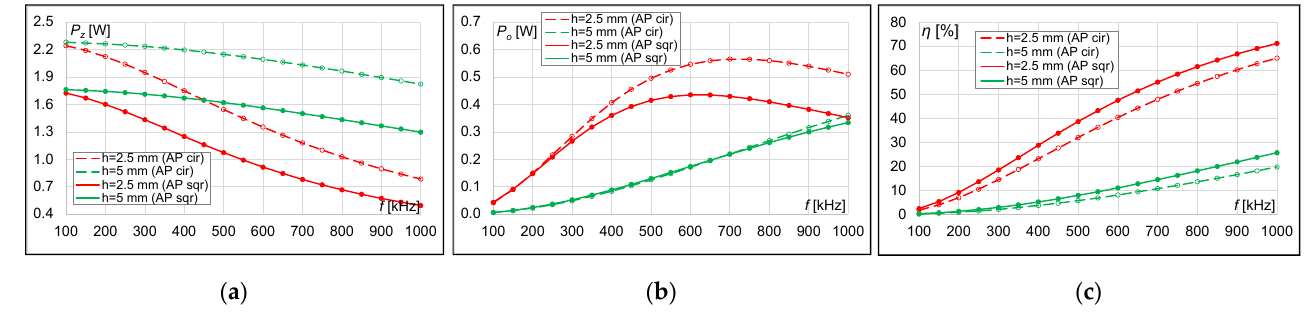
Figure 25. Results for the aperiodic system with circular or square coils with r = 5 mm and the number of turns n = 20 at two distances ( h = 2.5 mm and h = 5 mm): ( a ) transmitter power, ( b ) receiver power, ( c ) power transfer efficiency.